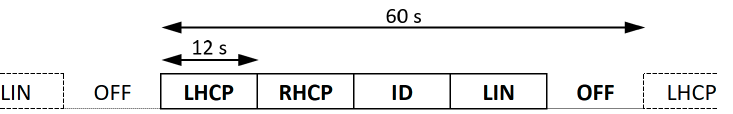
Figure 7. Example of a sequence of polarized probing signals. This example shows left-hand circular polarization (LHCP), right-hand circular polarization (RHCP), transmitter identification (ID) and linear polarization (LIN). The ‘off’ interval is used to synchronize probe and sensor.